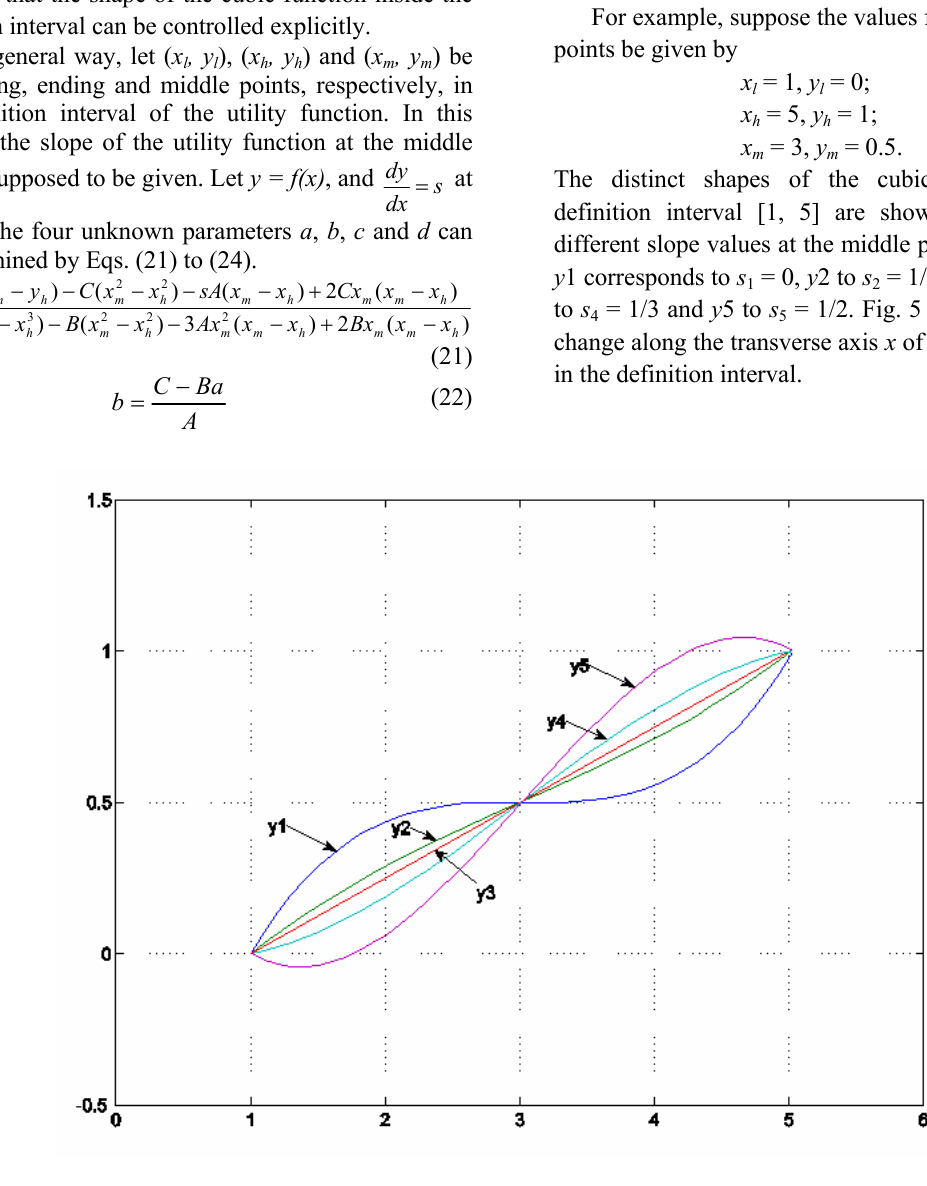
Fig. 4. Cubic utility functions with varying slopes at the middle